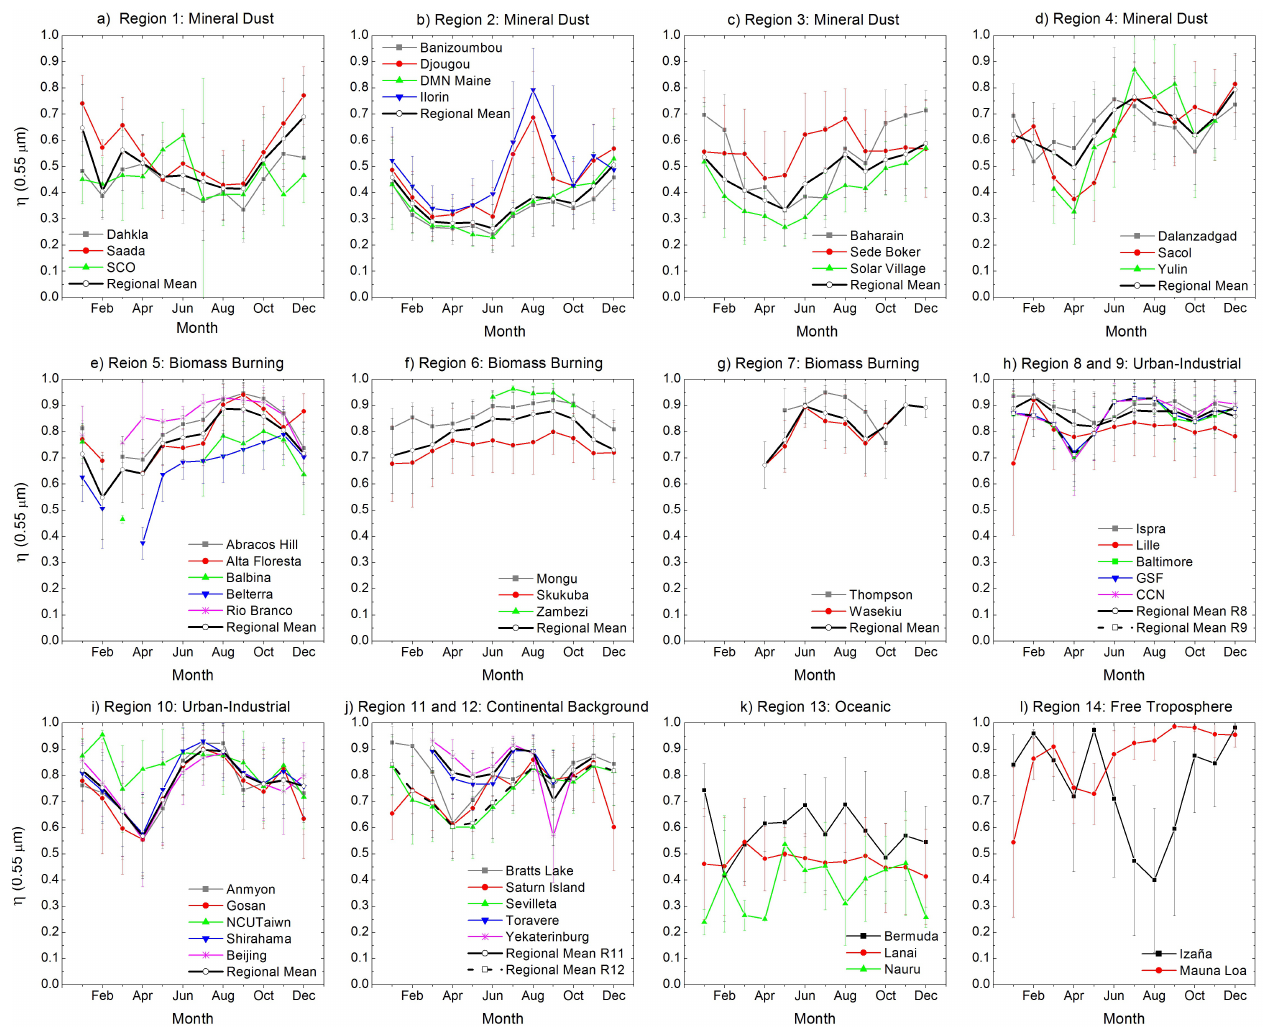
Fig. 3. Monthly evolution of the multi-year regional average of the fine aerosol fraction, η , at 0.55µm for each station of region 1 (a) , region 2 (b) , region 3 (c) , region 4 (d) , region 5 (e) , region 6 (f) , region 7 (g) , region 8 and 9 (h) , region 10 (i) , region 11 and 12 (j) , region 13 (k) and region 14 (l) . The annual cycle of the regional mean is also shown (black lines). Error bars indicate ± 1 σ ( σ , standard